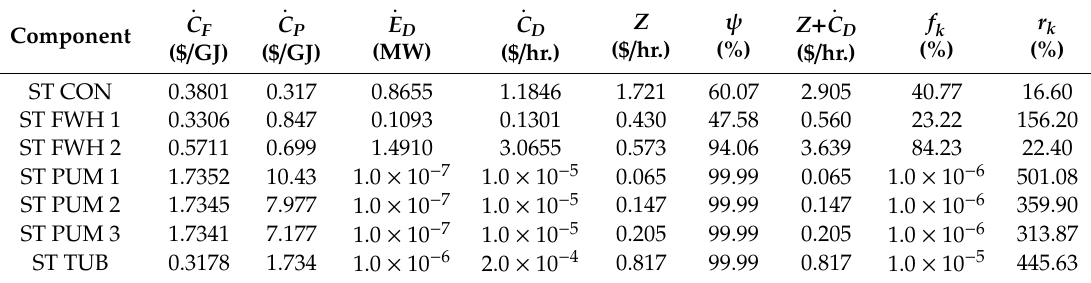
Table 10. Exergoeconomic parameters for the steam turbine plant.